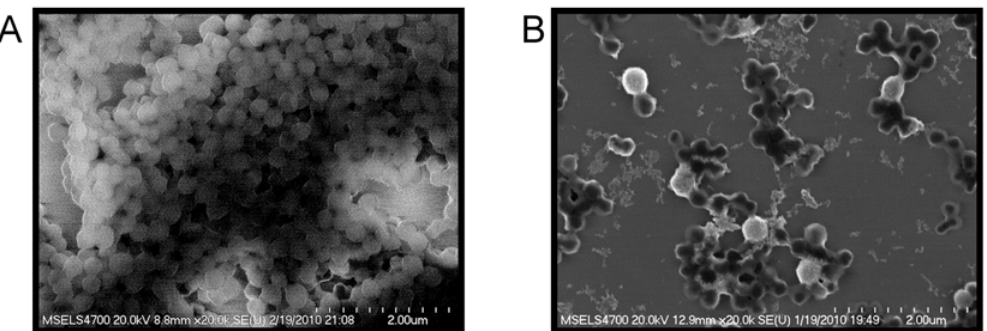
Figure 4. Scanning electron microscopy (SEM) image of pAm-based hydrogel